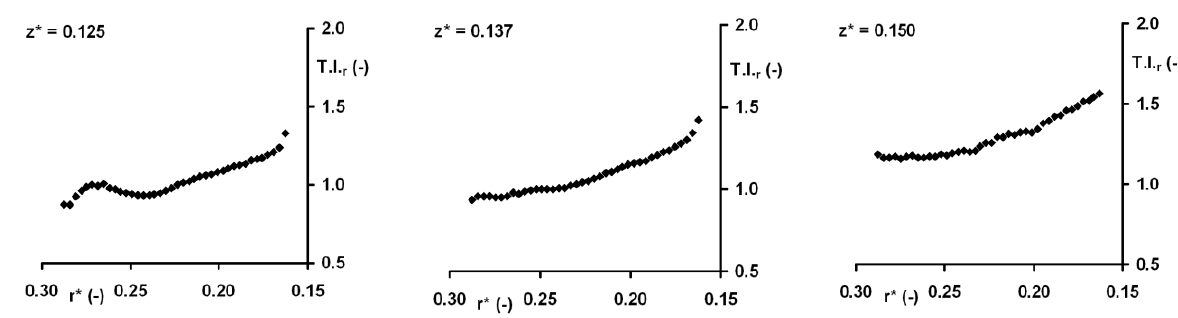
Fig. 11. Radial turbulence intensity profiles T.I. r = f ( r *